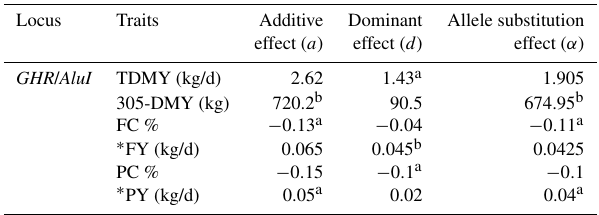
Table 4. Genetic effects of GHR / AluI polymorphism on milk- related traits in the Jersey breed. Locus Traits